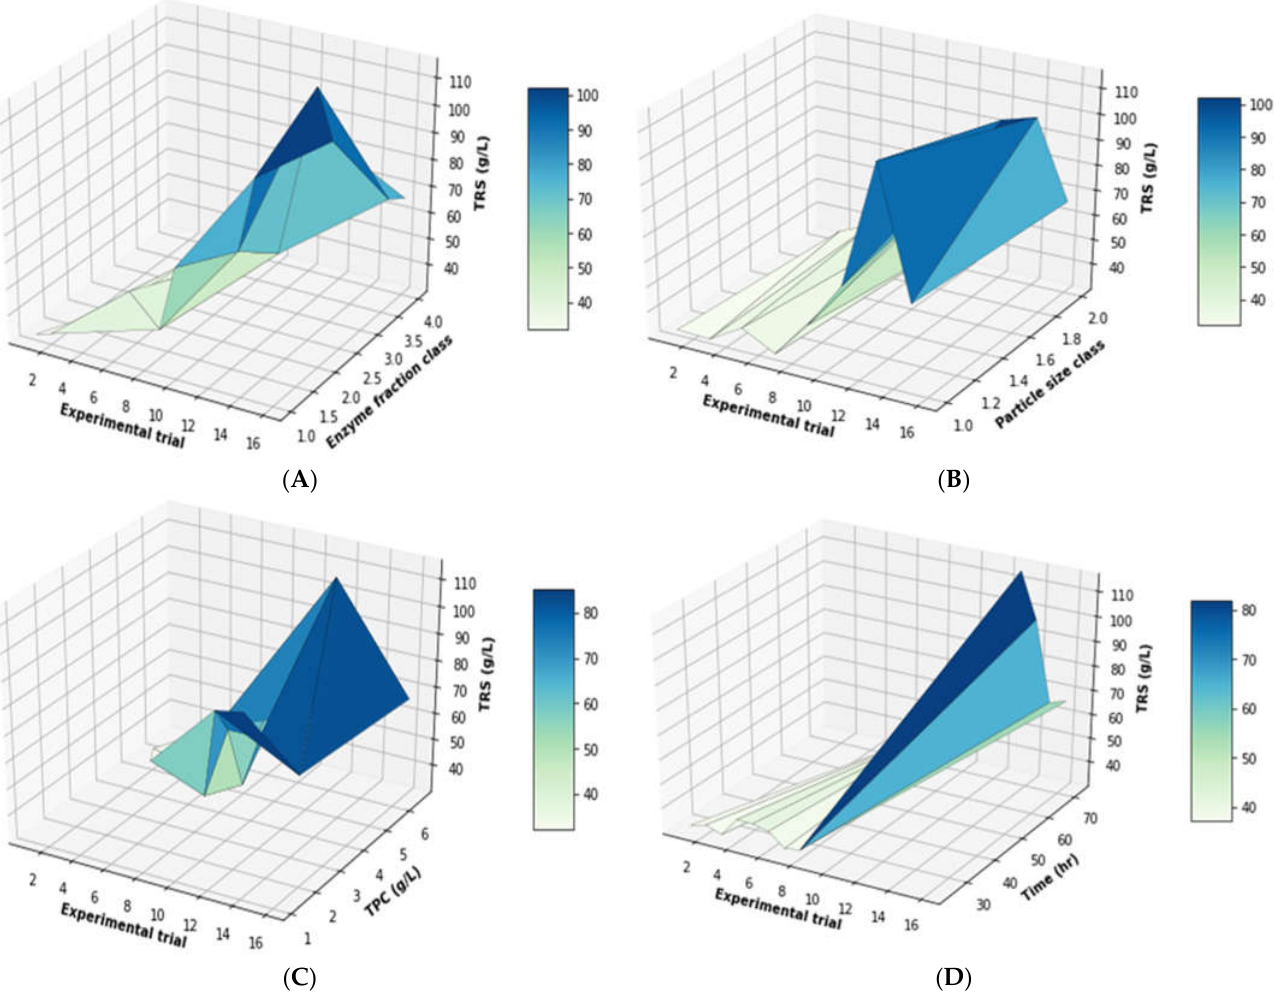
Figure 3. 3-D plots of the variation of TRS production with the enzyme fraction class ( A ), particle size class ( B ), time ( C ), and TPC generation ( D ). Refer to Table 5 for the enzyme fraction and particle size classes.